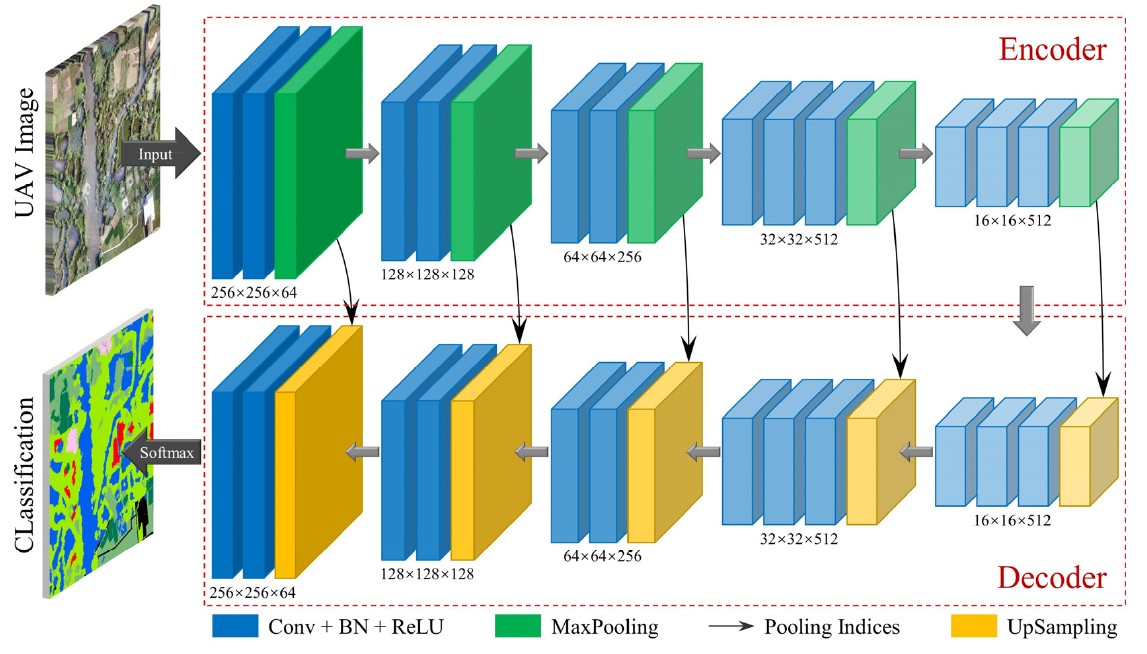
Figure 4. Structure of the SegNet algorithm.